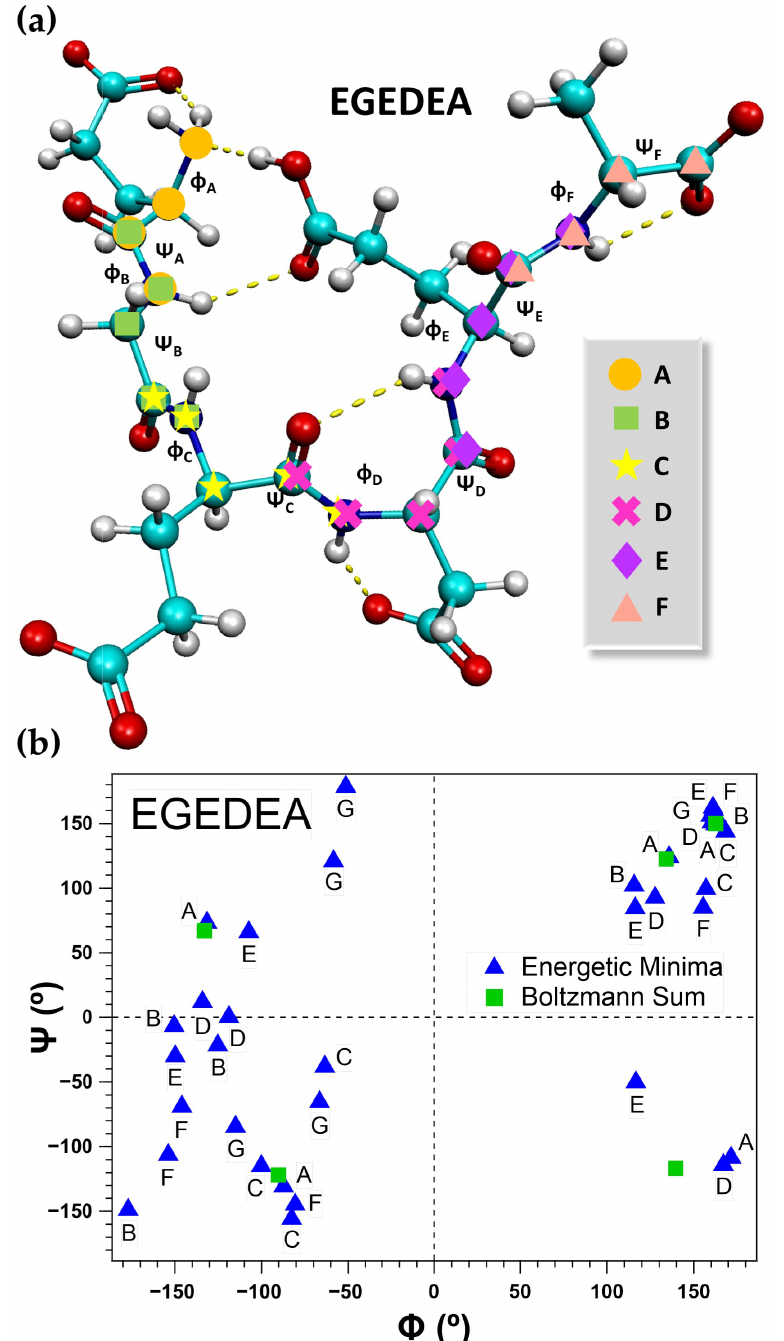
Figure 5. ( a ) Computed molecular geometry of the lowest energy conformation of EGEDEA, A, with the assigned Φ and Ψ bond angles (presented in degrees, ◦ ) labeled for each peptide bond. ( b ) Ramachandran plot of the computed ϕ and ψ bond angles for each of the considered energetic minima of the EGEDEA hexapeptide, presented in degrees ( ◦ ). The Boltzmann sums of the weighted values are also